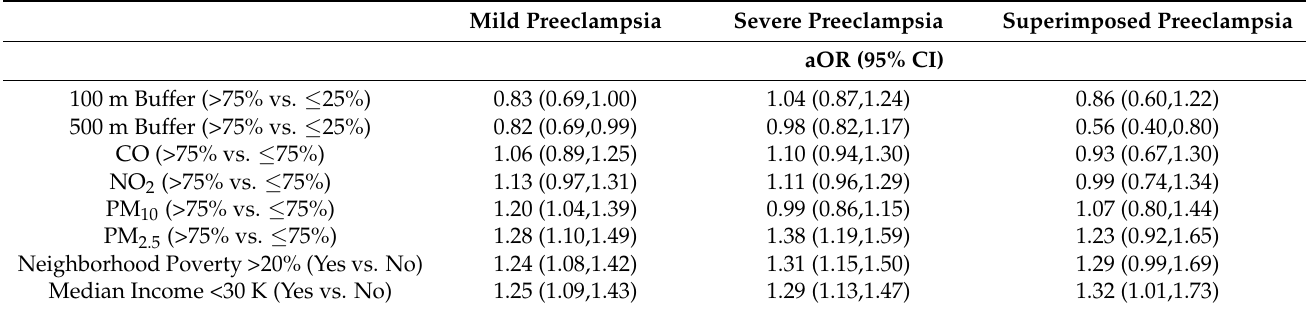
Neighborhood Poverty >20% (Yes vs. No) 1.24 (1.08,1.42) 1.29 (0.99,1.69) Median Income <30 K (Yes vs. No) a Adjusted for maternal age (years), race/ethnicity (non-Hispanic white, U.S.-born Hispanic, foreign- born Hispanic, non-Hispanic Black, Other), season of conception (winter, spring, summer, and fall), parity (1, ≥ 2). b Only women without a missing covariate were included in adjusted